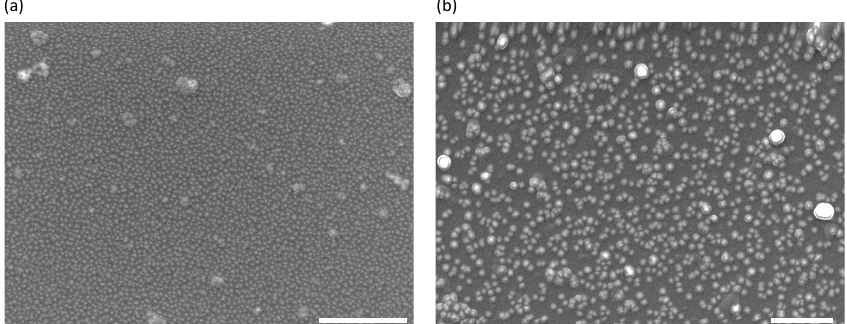
Figure 2. SEM micrographs of spherical gold NP Langmuir–Blodgett (LB) monolayers prepared at 12 mN m − 1 of lateral pressure and without further gold electroless plating. Images correspond to NPs of 5 nm ( a ) and 40 nm ( b ). Scale bars are 500